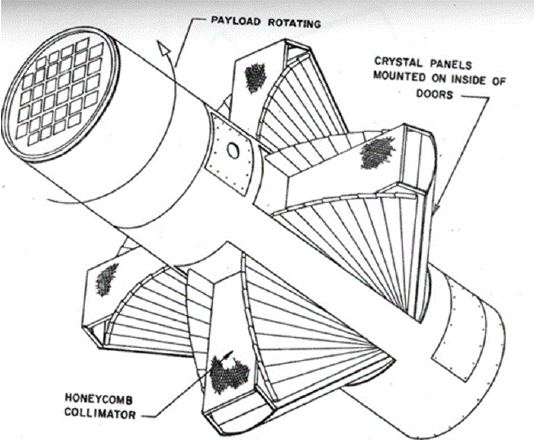
Figure 3. Schematic of sounding rocket 17.09 which featured both lithium scattering polarimeters in the forward section of the payload and four mosaic graphite crystal Bragg polarimeters, each mounted at an average angle of 45 degrees to the incident flux and featured proportional counters as detectors. The doors opened once the payload achieved altitude.